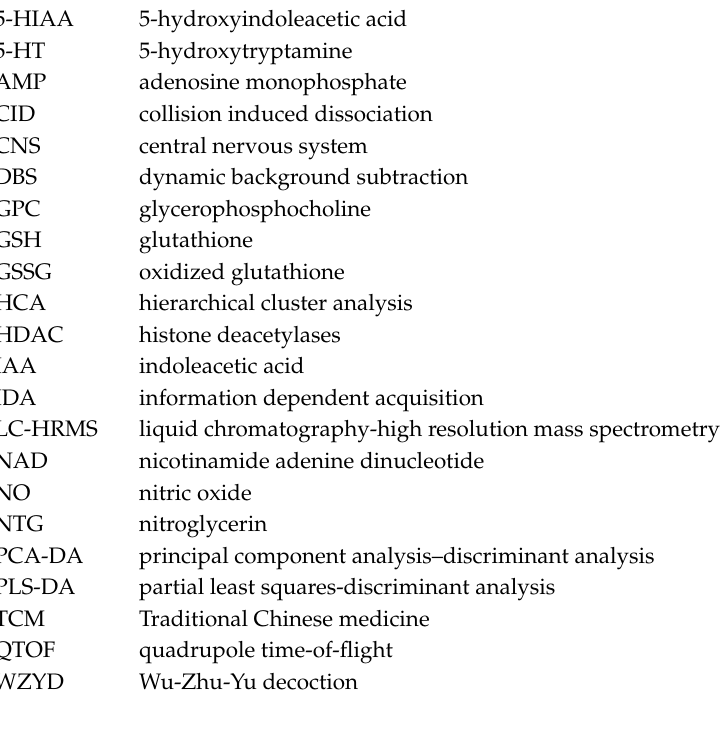
Supplementary Materials: The following are available online. Figure S1: TOF MS total ion chromatograms of representative brain homogenates samples from (A) control, (B) model, (C) WZDY and (D) flunarizine group; and plasma samples from (E) control, (F) model, (G) WZDY and (H) flunarizine group in positive ion mode; Figure S2: Extracted ion chromatograms of the potential metabolite biomarkers found in both brain and plasma metabolomics, (A) GPC, (B) Arginine, (C) AMP, (D) NAD, (E) GSH, (F) GSSG, (G) Adenine, (H) Adenosine, (I) Valerolactam, (J) Butyrylcarnitine, (K) Caprolactam and (L) Cholecalciferol in brain; (M) Arginine, (N) Carnitine, (O) 5-HIAA, (P) 3-Methylindole, (Q) Hydroxyindole and (R) IAA in plasma; Figure S3: VIP scores analysis based on weighted coefficients of the PLS-DA model used to rank the contribution of the metabolites to the discrimination between the four groups; Figure S4: Integrated metabolic network in headache subjects. Altered metabolites were mapped to KEGG and SMPD reference pathways and interaction networks were generated in Cytoscape. The network nodes (blue and pink) represent pathways and related metabolites detected, respectively; Table S1: Comparison of the times of head-scratching of the rats ( n = 15) in 2 h; Table S2: The database information of the potential biomarkers and their trends in headache rat brain tissue; Table S3: The database information of the potential biomarkers and their trends in headache rat plasma; Table S4: Principle metabolic pathways of the metabolites in KEGG